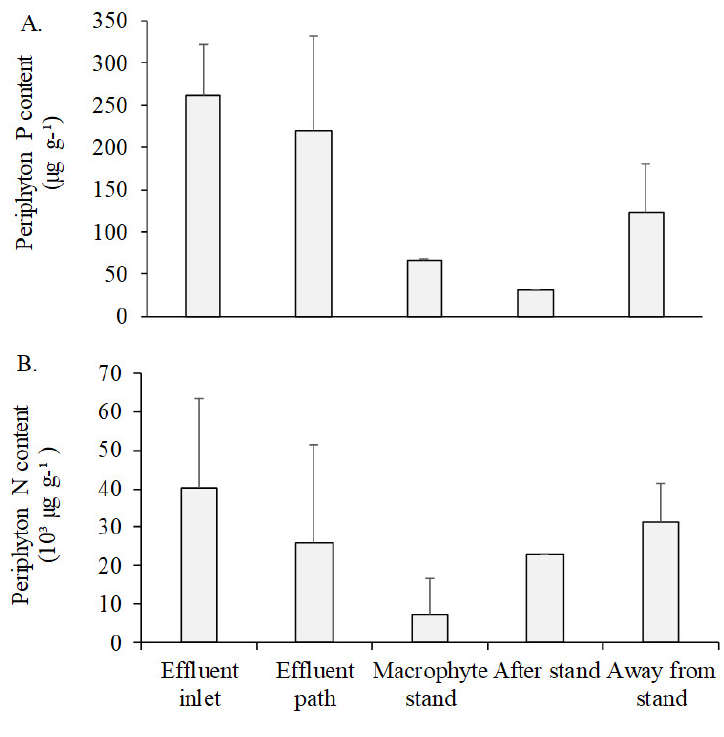
Figure 5. Periphyton N and P contents (mean; SD; n = 3) in the sampling